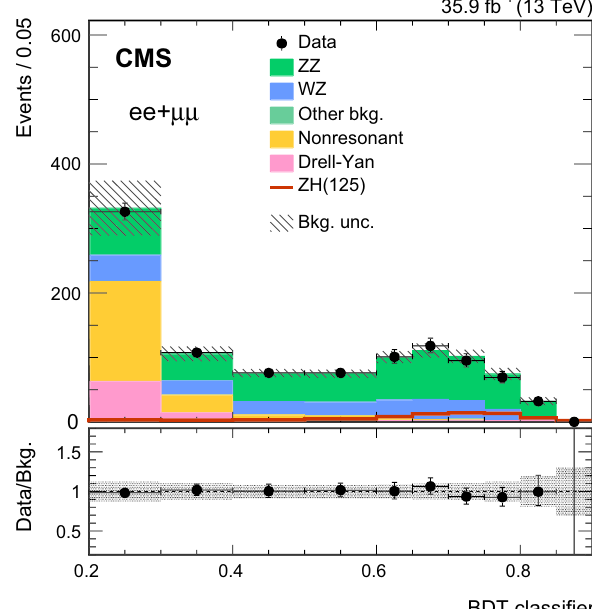
Fig. 8 Post-fit distribution of the BDT classifier in the multivariate analysis signal region for the SM H(inv.) decay hypothesis with B ( H → inv. ) = 100%.Uncertaintybandscorrespondtothecombinedstatistical and systematic components